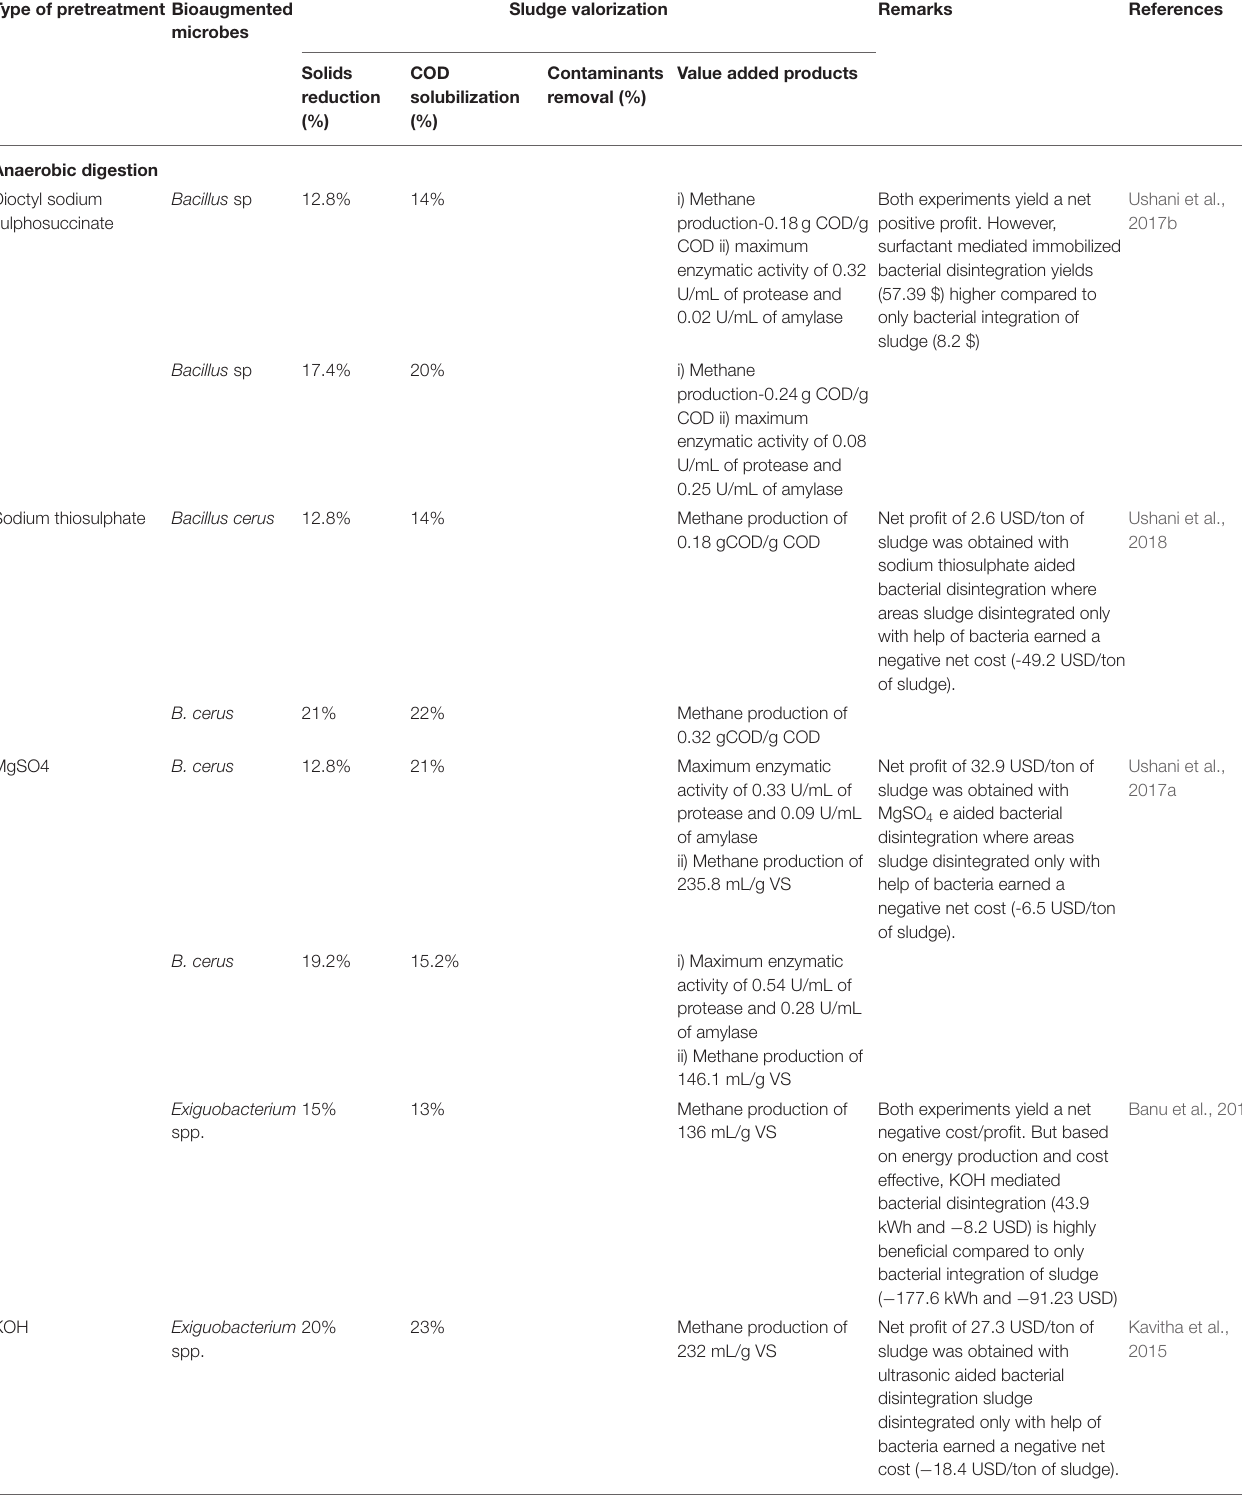
TABLE 3 | Summary of key information on pre-treatment assisted bioaugmentation aided biological